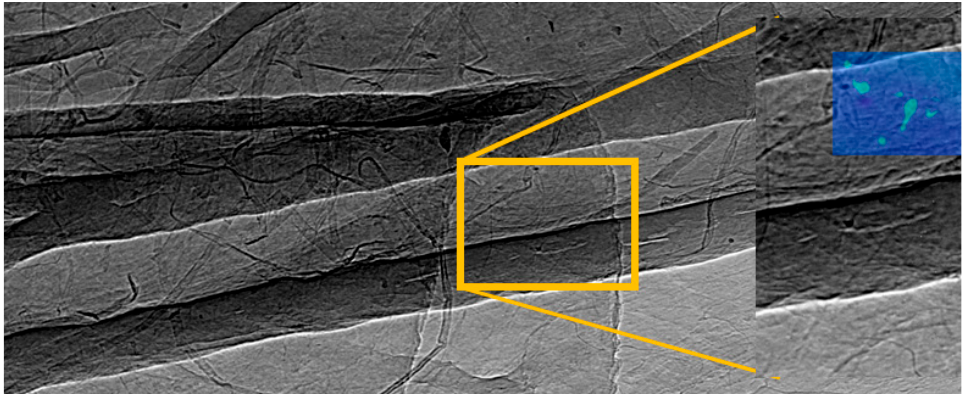
Figure 6. Radiographic image of a collagen matrix for a sample of proliferating cells with an overlaid optical image of a region of the matrix with stained nuclei of living cells.